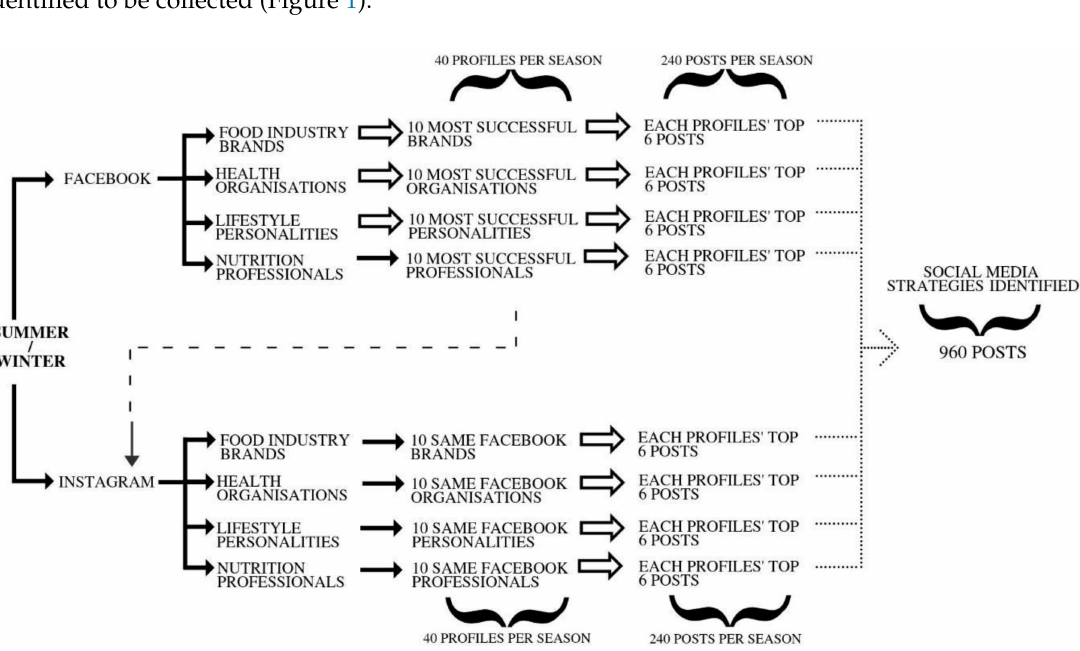
Figure 1. Graphical representation of study design. Solid arrows indicate steps where decisions were made by the researchers, i.e., including Facebook and Instagram rather than other platforms; including Food Industry Brands, Health Organisations, Lifestyle Personalities, and Nutrition Professionals as groups of interest. The top 10 NP profiles were selected by researchers based on criteria specified in the methods. The dashed arrow indicates where the Facebook data collection informed the Instagram profiles. Hollow arrows indicate that the data to the right was collected via Socialbakers © . Dotted arrows indicate the collection via the coding